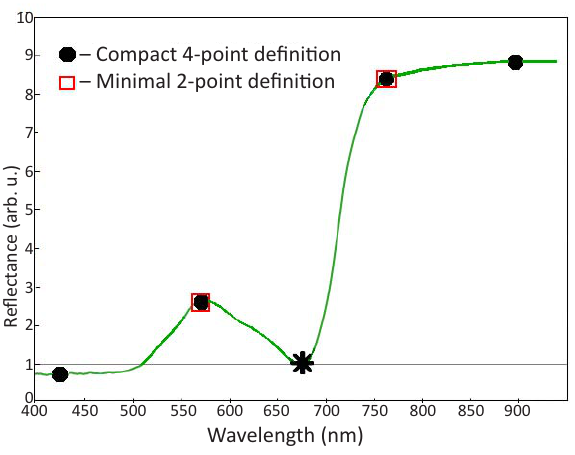
Fig. 4. Idea of approximate compact green vegetation reflectance model for the spectral range 400–900 nm. If the chlorophyll­ caused minimum near 670 nm is made equal to unit value, only four adjustment parameters will be needed for an approximate normalized description of spectra registered by HS camera type devices. In a maximally compact robust presentation only two parameters are needed: the relative heights of the green apex and the red edge step. It is assumed that the wavelengths of the characteristic points are approximately constant and the possible small shifts of 10–20 nm due to the variations of photosensitive pigments may be disregarded.